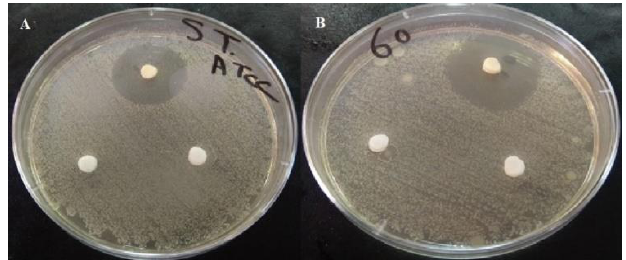
Figure 3. The minimum inhibitory concentration (MIC) of the active fraction of Streptomyces sp. DH7 was tested against S. aureus ATCC 6538. A stock solution of the active fraction dissolved in an equal amount of DMSO was used to prepare different concentrations, namely 0.5, 1, 2, 4, 8, 16, 32, 64, 128, and 256 μg/μL. An aliquot of 5 μL from an overnight culture of S. aureus ATCC 6538 (0.5 Mcfarland) was added to each well of sterile 96-well flat-bottomed microtiter plates containing the test concentrations of the active fraction. Then, optical densities were recorded using a multi- detection microplate reader (Bio-Tek-Synergy HT Microplate Reader, BioTek Instruments, Winooski, VT, USA) at 600 nm.